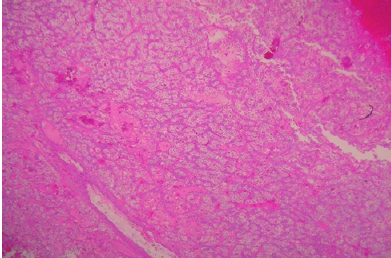
Figure 1. Vaginal metastases from renal cell carcinoma, clear cell type. Microscopic examination of the tumor from the vagina reveals the compact alveolar architecture of cells with clear cytoplasm and distinct cell boundaries in a background of delicate vasculature. (H&E stain; magnification 100X.)